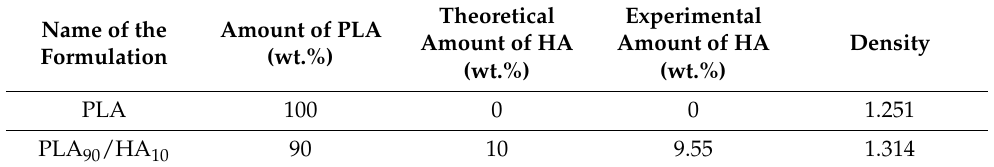
Table 1. Nomenclature of the samples, theoretical and experimental amounts of HA, and sample density. Name of the